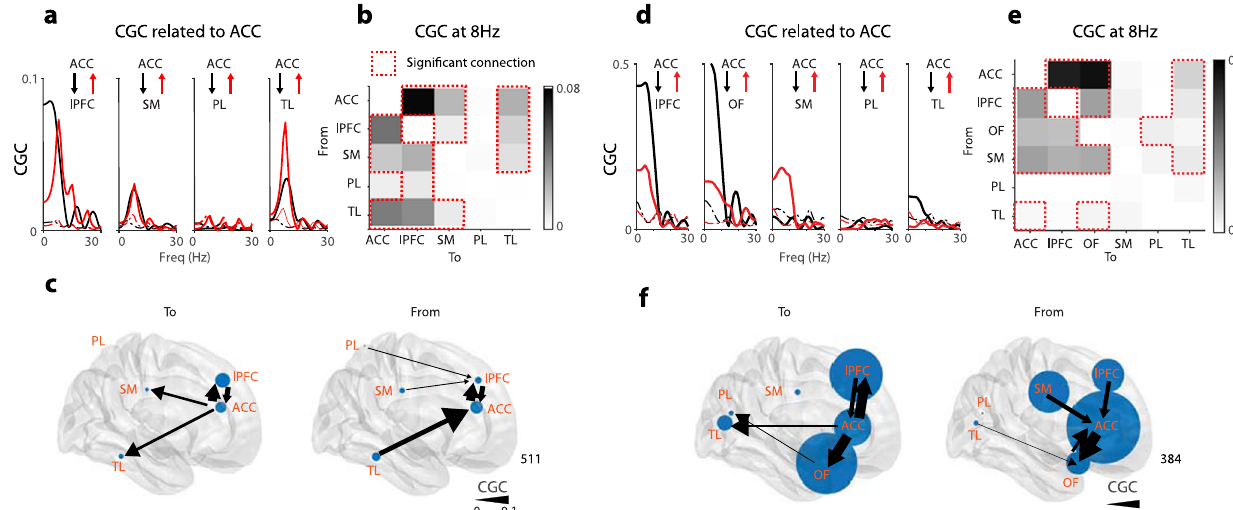
Fig. 6 | Results ofConditional Granger causalityofintracranial fi eldpotentials in two patients. a Averaged spectral Conditional Granger causality (CGC) related to anterior cingulate cortex (ACC) across 12 sessions of esTT experiment in PT511. x-axis indicates iEEG frequency in Hz and y-axis indicates magnitude of CGC. Solid lines represent CGC calculated from actual data and dotted lines represent 95% CGC values found withphase-randomized surrogate data. b Averaged CGC among 5ROIgroups.PeakCGCvaluesat8Hzwereshown.ColorbarrepresentsCGCvalues at 8Hz. The cells in the matrix surrounded by the red dotted lines indicates sig- ni fi cant CGC (over 95% point from phase-randomized surrogate data distribution). c Effective connectivity (CGC) plotted on the MNI brain among ROIs. Thickness of